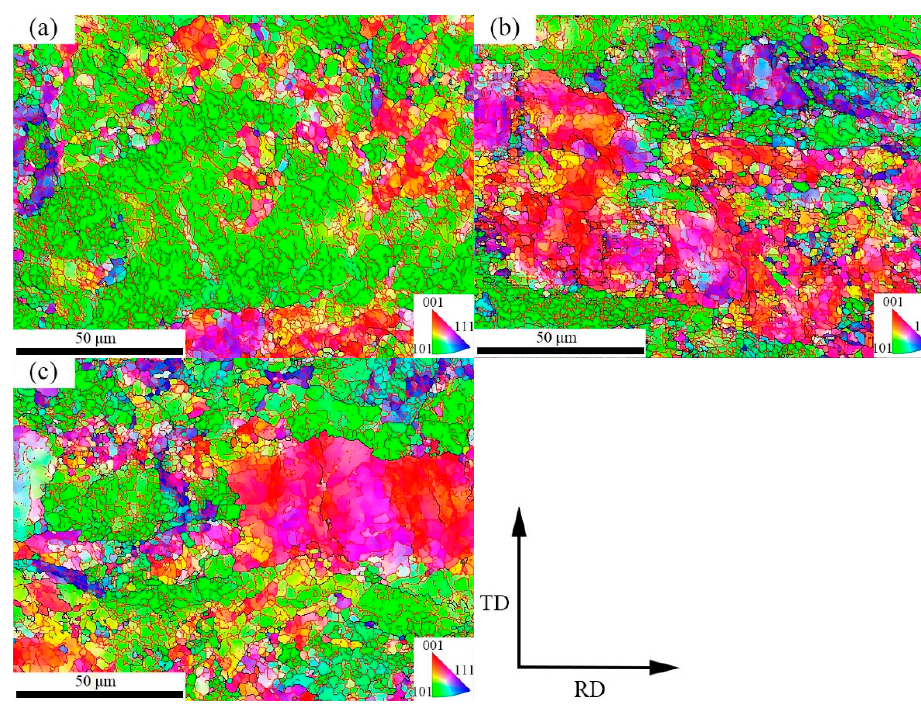
Figure 3. EBSD surface IPF (inverse pole figure) orientation maps of samples rolled with different reduction rates; ( a ) 800 °C—88%, ( b ) 800 °C—78%, ( c ) 800 °C—67%.